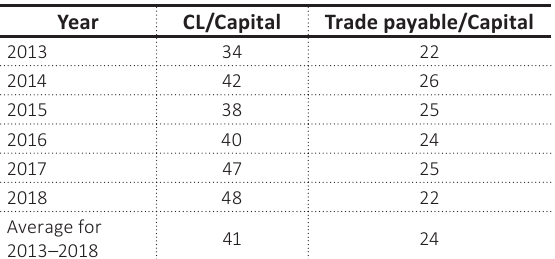
Table 3. The role of the current liabilities in the formation of the enterprises’ financial